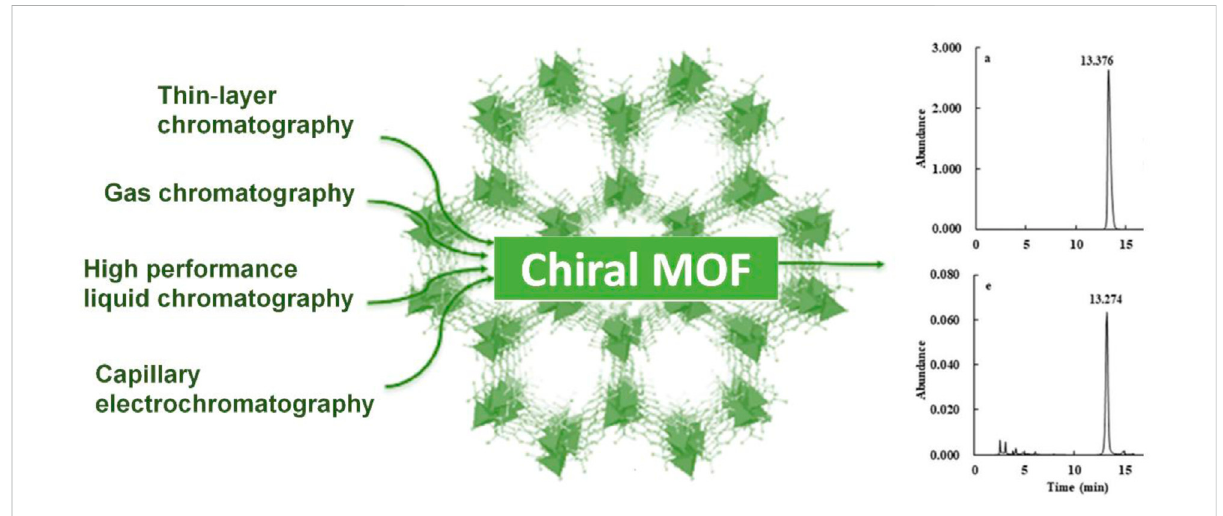
FIGURE 6 Applications of chiral MOFs in